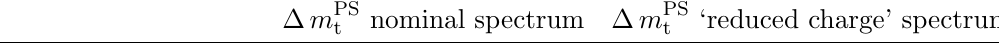
. The sign of the s s